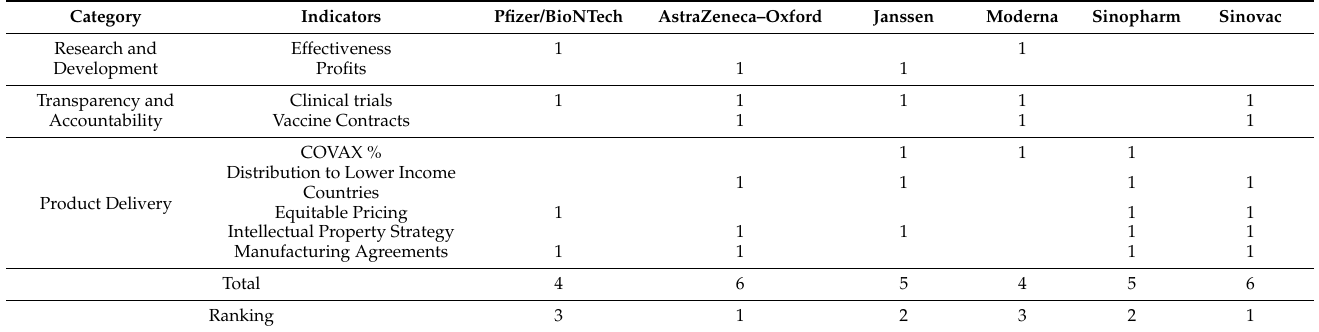
Table 8. Scoring of the EUL vaccine